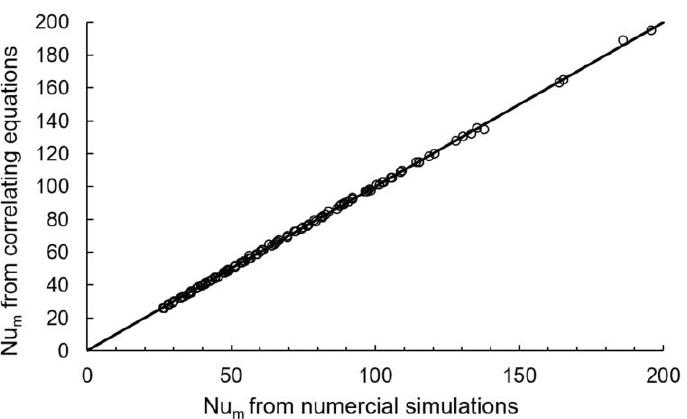
Figure 19. Comparison between new correlating equations and numerical results.